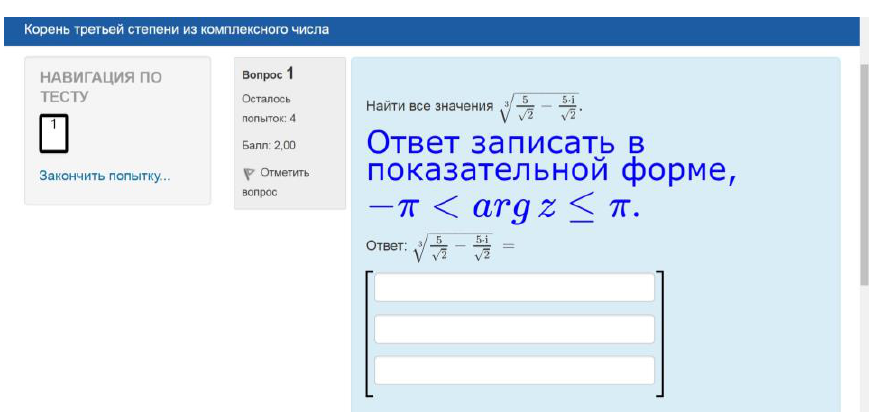
Fig. 1. STACK type task on finding complex roots (TUSUR) / the third-degree root of the complex number/test navigation, finish the attempt / question, attempts left, score, mark the question / find all values of, enter the answer in an exemplary